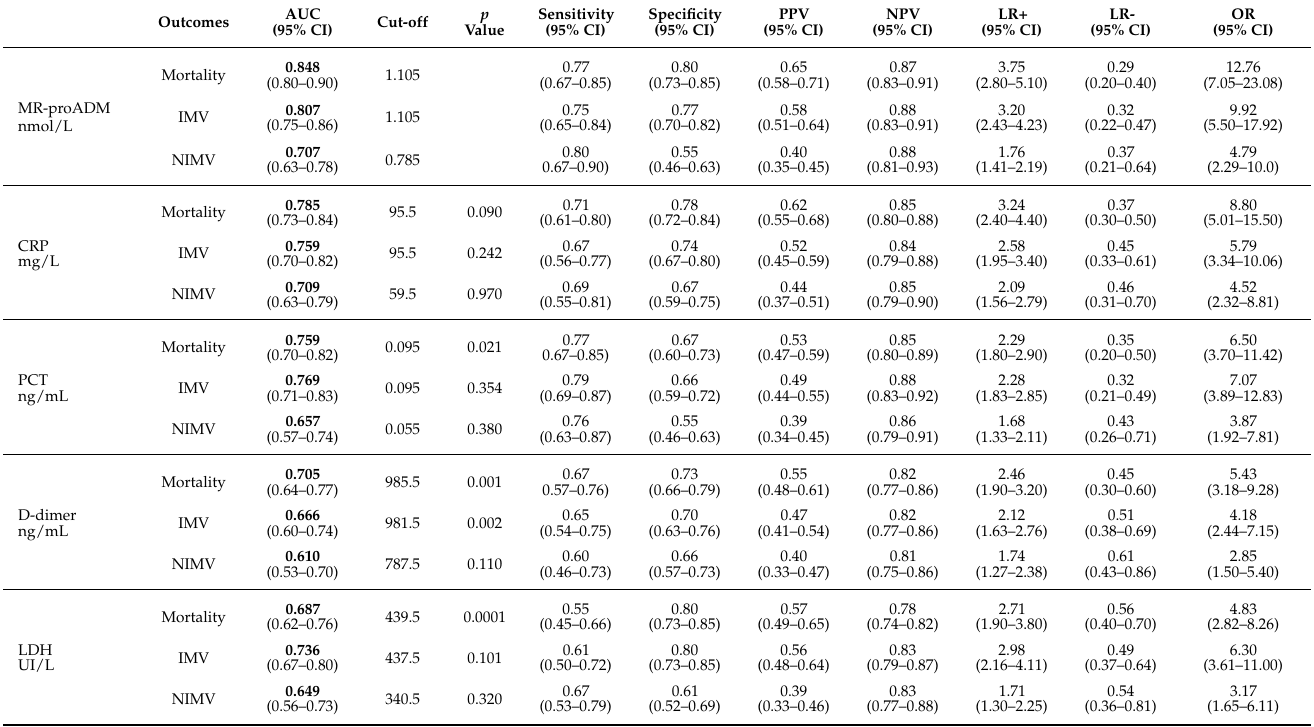
Table 5. Prognostic accuracy of biomarkers for different